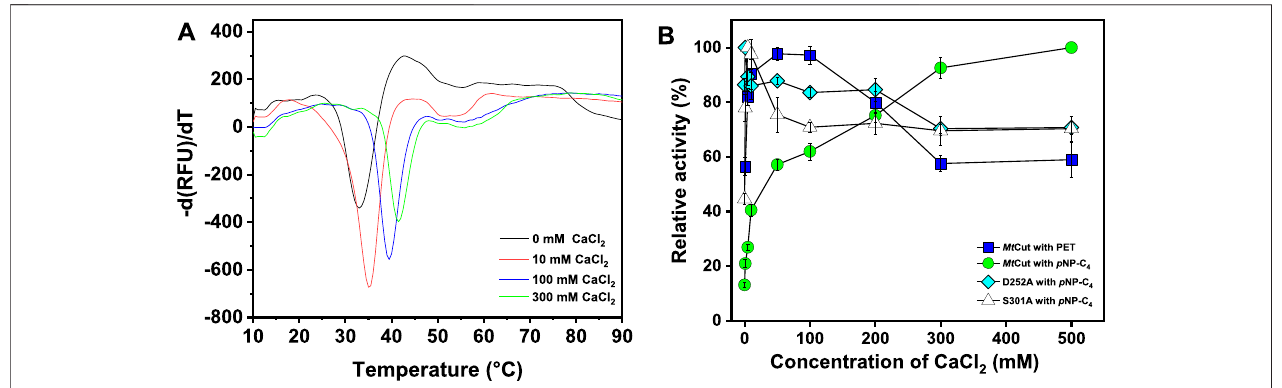
FIGURE 2 | The effects of Ca 2+ on Mt Cut thermostability and catalytic activity. (A) Mt Cut melting temperature curves at different CaCl 2 concentrations in DSF experiments. Protein unfolding was monitored by detecting SYPRO orange fl uorescence changes. (B) Comparison of cutinase and PET hydrolase activities in the absence/presence of different CaCl 2